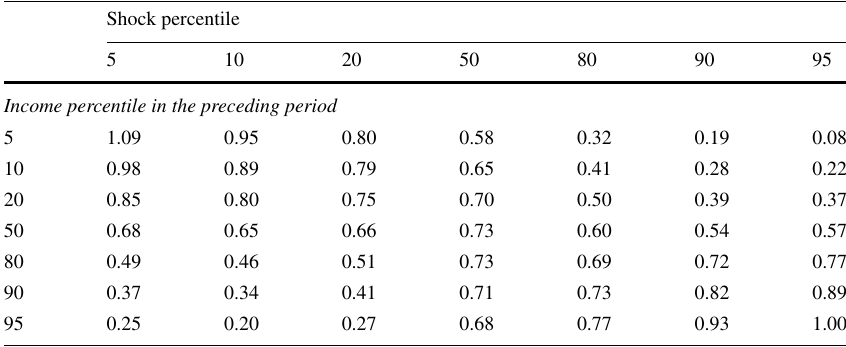
Table 4 Income persistence by size of the shock and income percentile (a). Source : Banco de España Shock